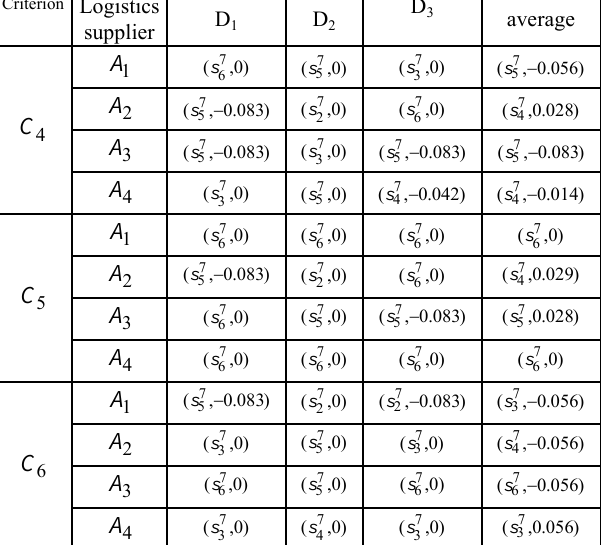
Table 13. Preference degree with respect to criterion